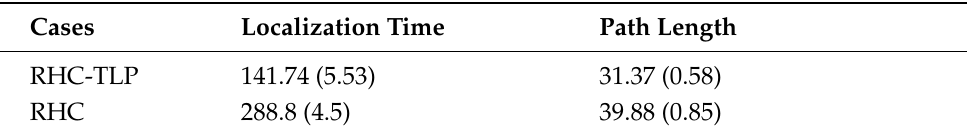
Table 3. Average (Standard error) results of localization time (s) and path length (m) in light of 30 runs for Case 2.